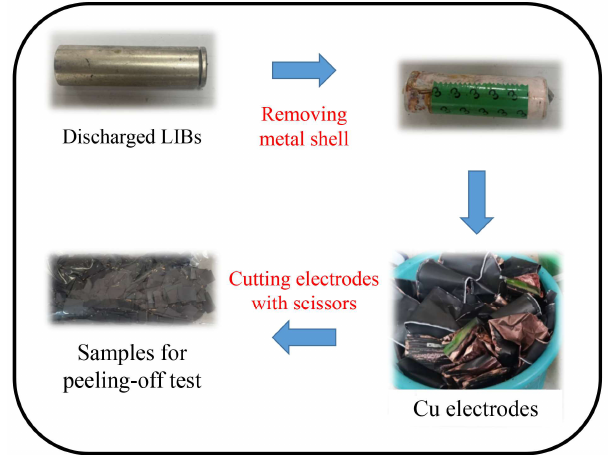
Figure 1. The schematical diagram of the preparation of the cut Cu electrodes.